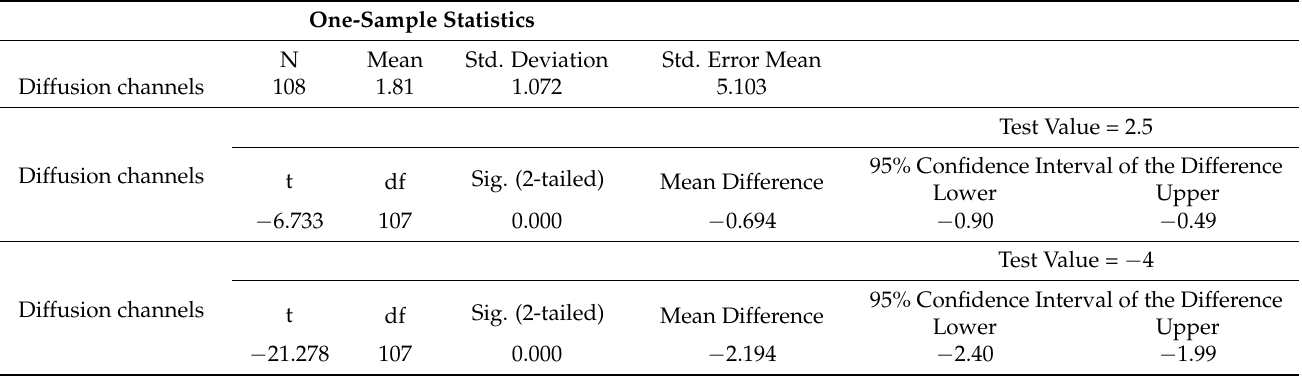
Table 2. One-sample